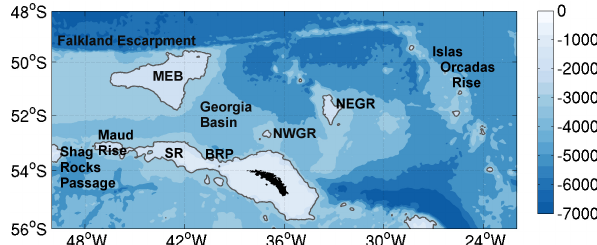
Fig. 2. Bathymetry and main topographic features in the South Georgia area: MEB: Maurice Ewing Bank; SR: Shag Rocks; BRP: Black Rocks Passage; NWGR: North West Georgia Rise; NEGR: Northeast Georgia Rise. Bathymetric contours for the 2000m are indicated with thin